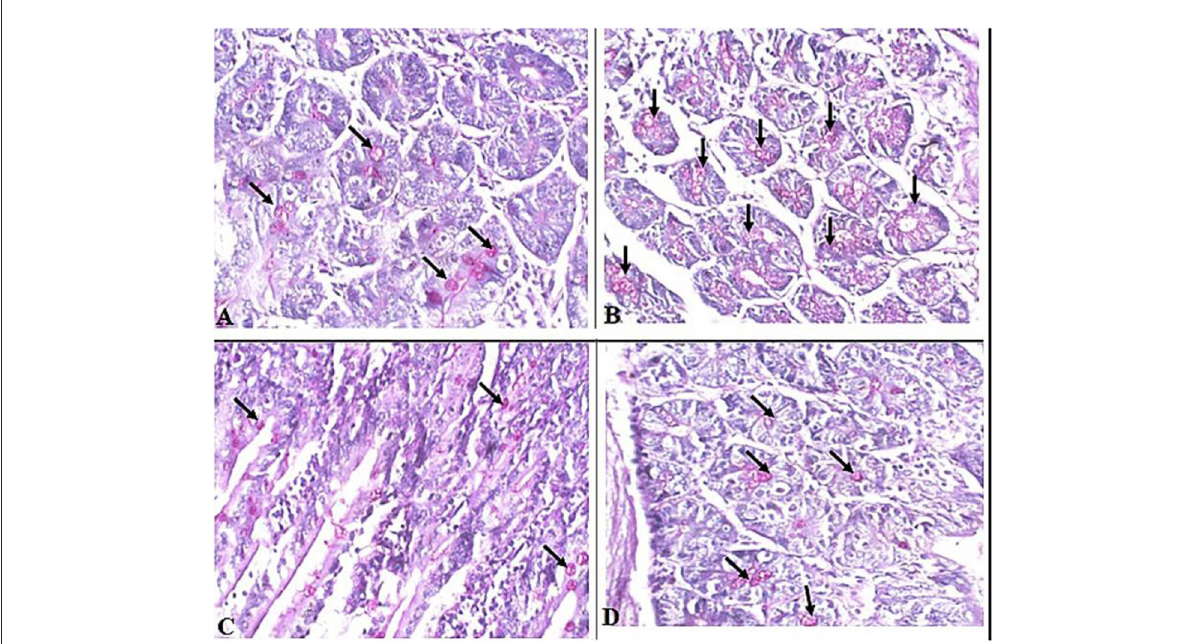
FIGURE4 Representative microphotographs of intestinal tissue of different groups of mice showing goblet cells. Periodic Acid Schiff’s (PAS) staining was performed to demonstrate goblet cells in intestinal tissues. (A) Uninfected mice. (B) Infected untreated mice. (C) Intestinal tissue of mice treated with A. annua ethanolic extract. (D) Intestinal tissue of mice treated with albendazole (positive control). Black arrows point to goblet cells. Magnification, 400x.